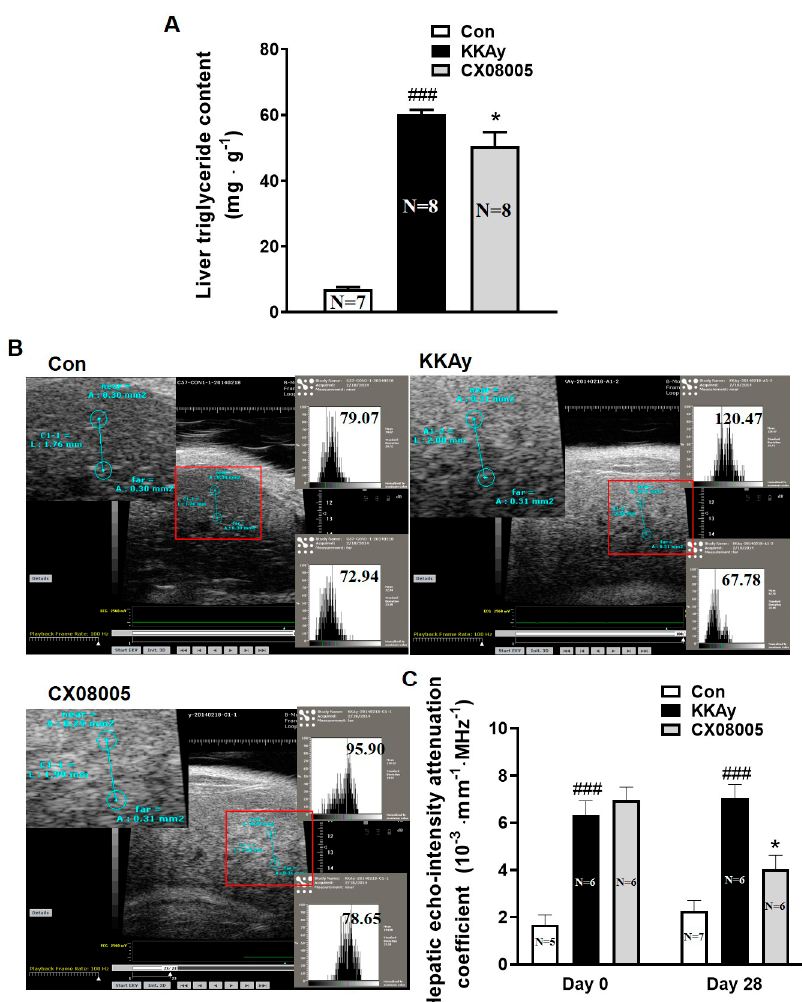
Figure 1. The effects of CX08005 on hepatic lipid accumulation in KKAy mice. ( A ) Quantitative analysis in hepatic triglyceride (N = 7–8). ( B ) Representative images of liver ultrasound after the treatment with CX08005 for 28 days. ( C ) Analysis of the hepatic echo-intensity attenuation coefficient after the treatment with CX08005 for 4 weeks (N = 5 − 7). Data are expressed as mean ± SEM ### p < 0.01 vs. Con; * p < 0.05 vs. KKAy.